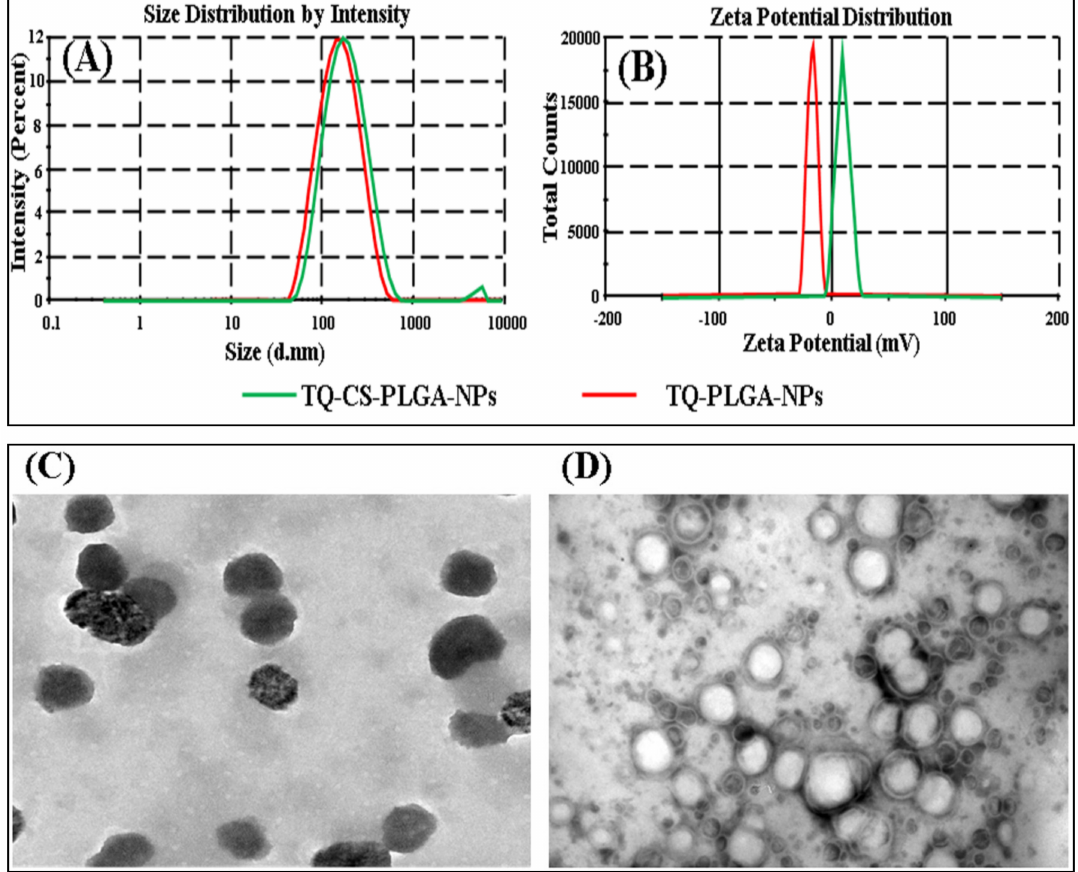
Figure 4. ( A , B ). Image showing ( A ) particle size and particle size distribution, ( B ) zeta potential of optimized TQ-CS-PLGA- NPs and TQ-PLGA-NPs. ( C , D ). TEM analysis of ( C ) optimized TQ-PLGA-NPs, and ( D )